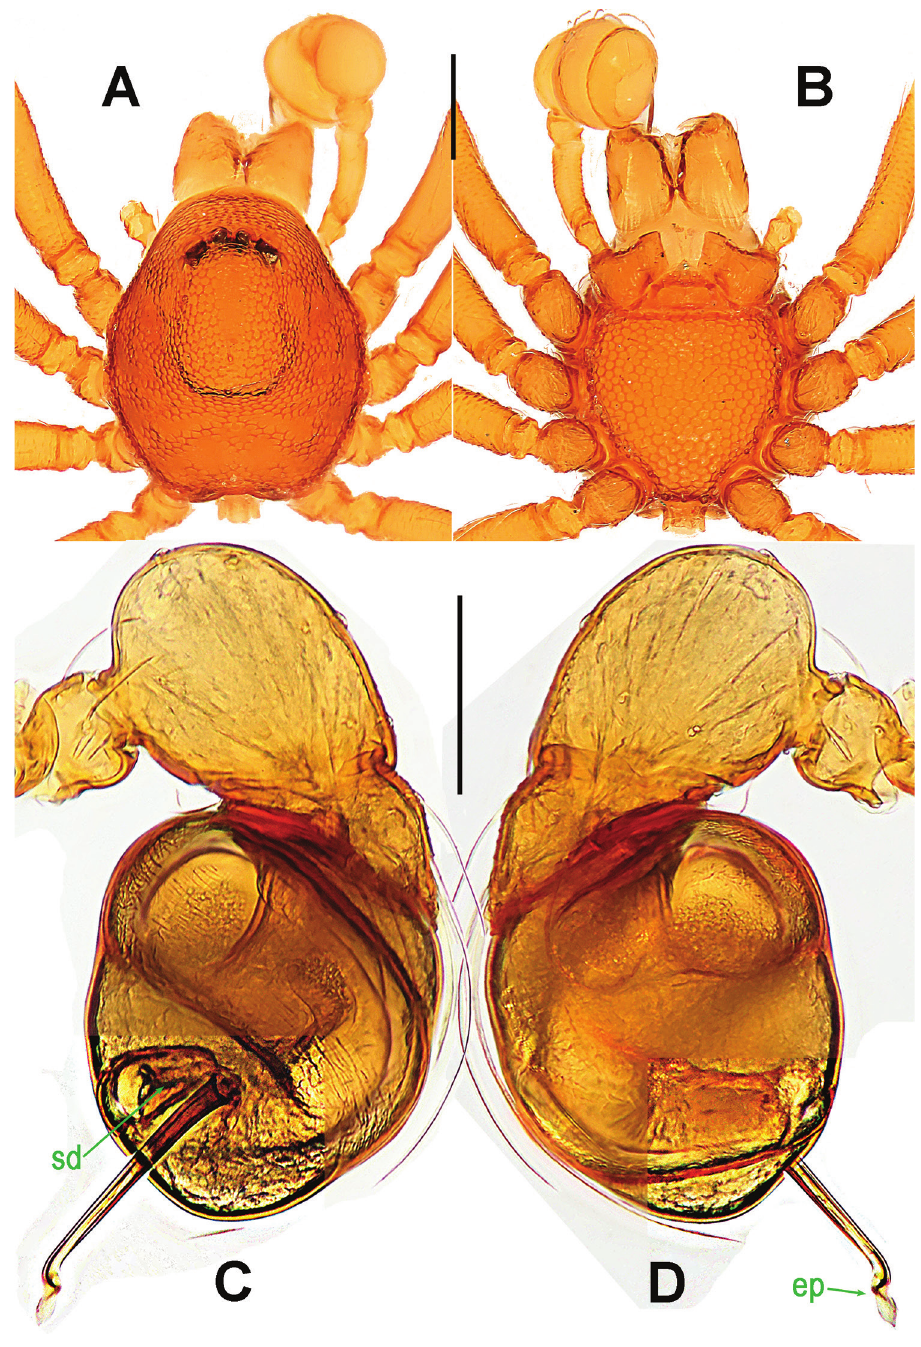
Figure 21. Singaporemma halongense Lehtinen, 1981, male paratype. A prosoma, dorsal B ditto , ventral C left palp, prolateral D ditto , retrolateral. Abbreviations: ep = embolic part of apes of palpal organ; sd = spermatic duct. Scale bars: 0.10